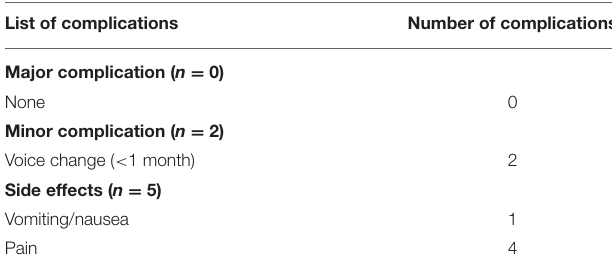
TABLE 3 | Complications and side effects after RFA.